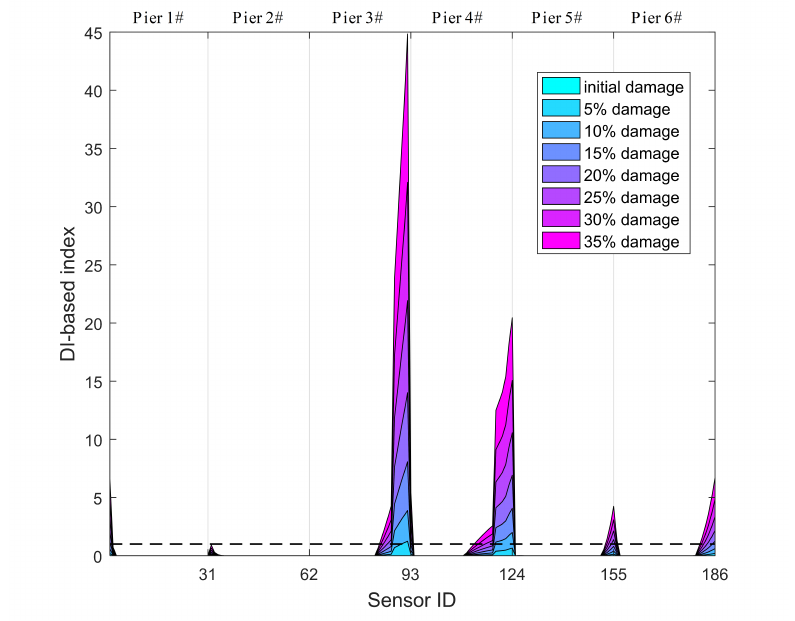
Figure 16. Identification results for Damage II using WPE-based method for all six